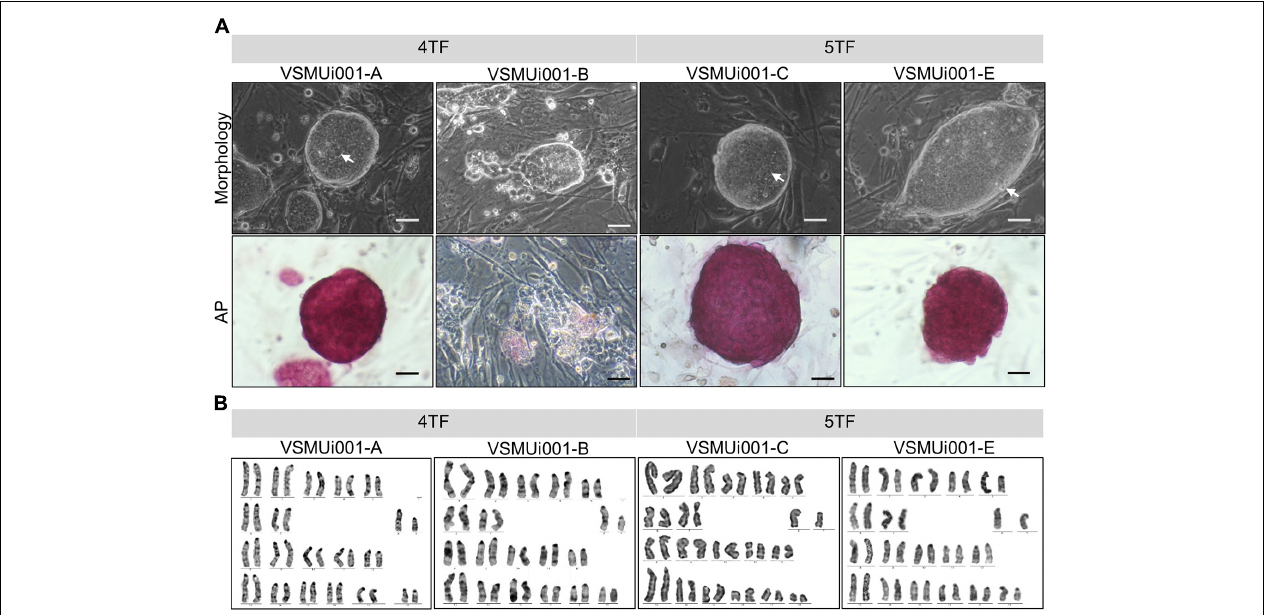
FIGURE 2 | Characterization of piPSCs. (A) Colony morphology and alkaline phosphatase (AP) staining of various piPSC lines; scale bar, 20 µ m. (B) Karyotypes of the various piPSC lines. 4TF, induction using OCT4, SOX2, KLF4, and C-MYC; 5TF, induction using OCT4, SOX2, KLF4, C-MYC, and LIN28. AP, alkaline phosphatase; piPSCs, porcine-induced pluripotent stem